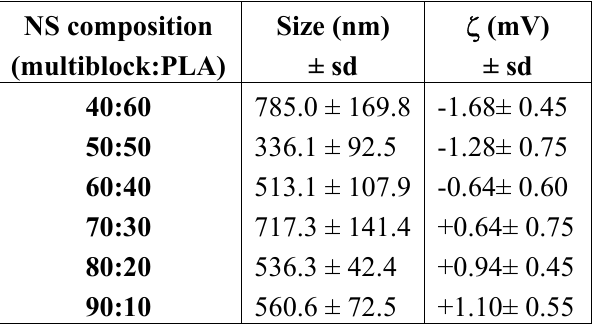
Table 4 : Zeta potential of nanoparticles made from PLA and multiblock